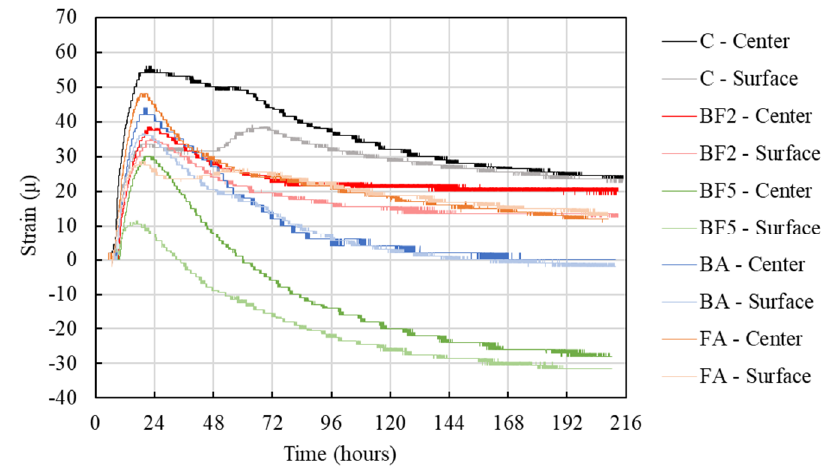
Figure 7. Thermal expansion.